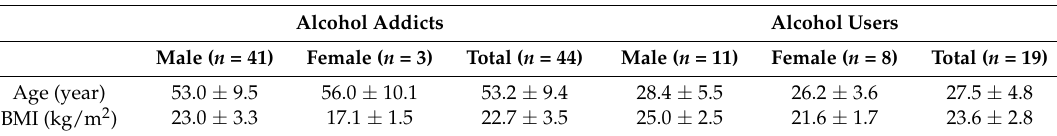
Table 1. Characteristics of alcohol addicts and alcohol